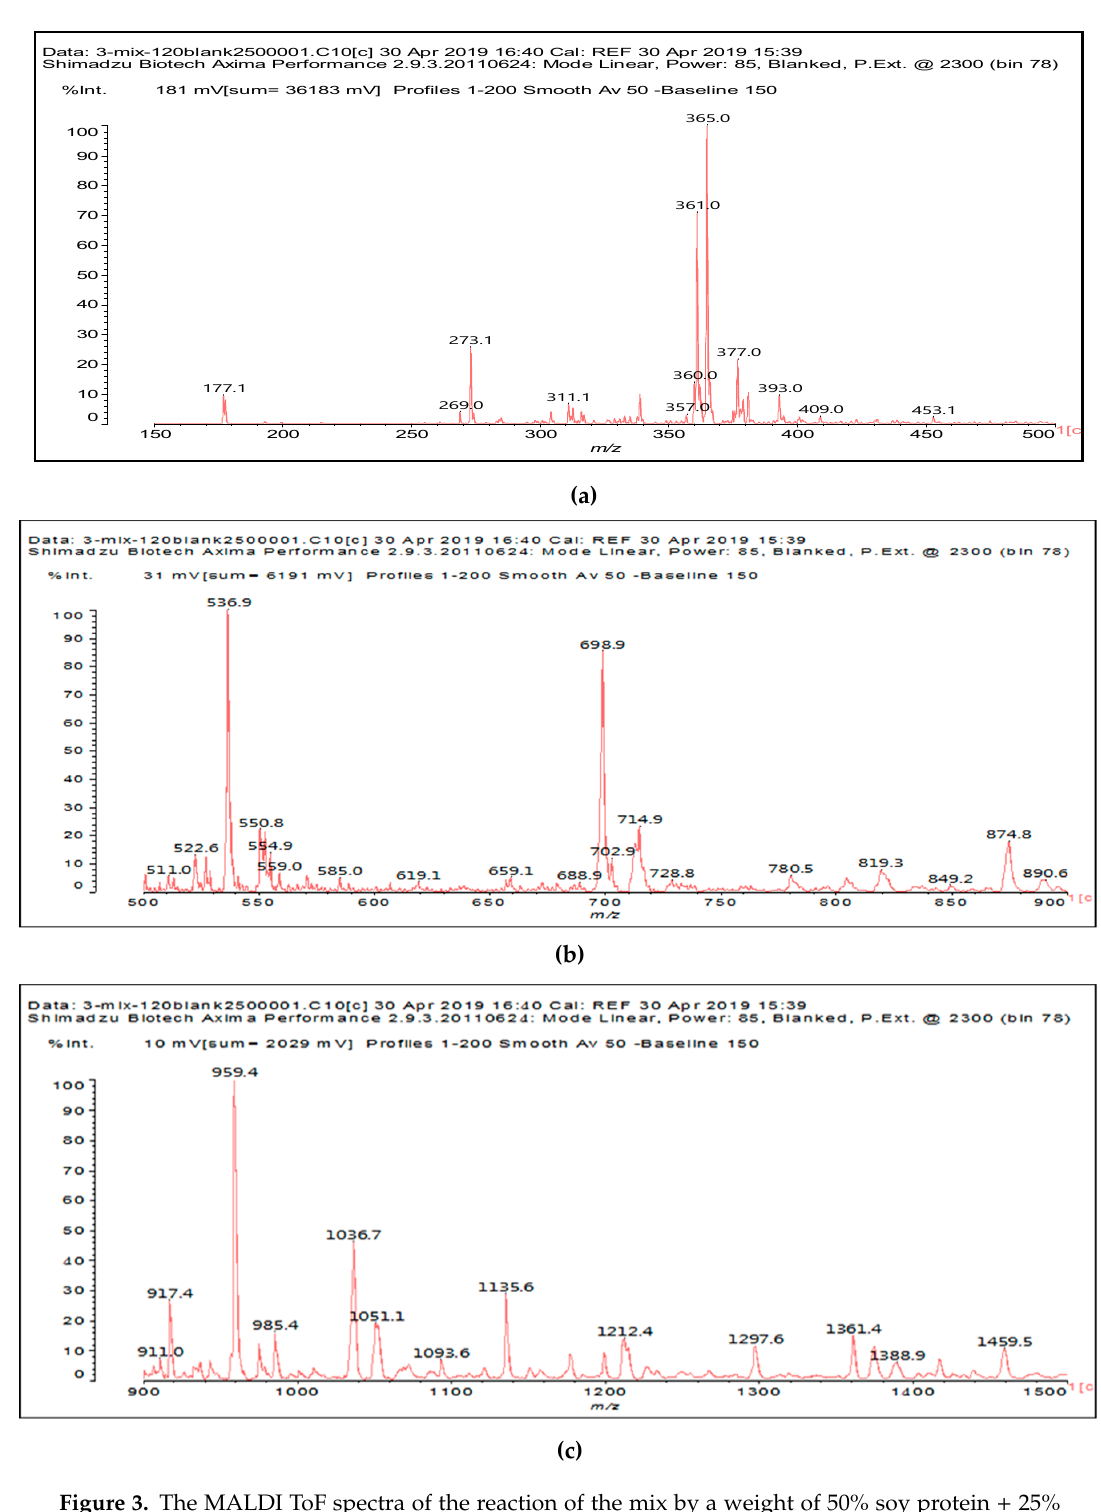
Figure 3. The MALDI ToF spectra of the reaction of the mix by a weight of 50% soy protein + 25% sucrose + 25% insoluble soy carbohydrates + 15% NaIO 4 at 120 ℃ for 1 hour. ( a ) 150 Da to 500 Da range. ( b ) 500 Da to 900 Da range. ( c ) 900 Da to 1500 Da range.